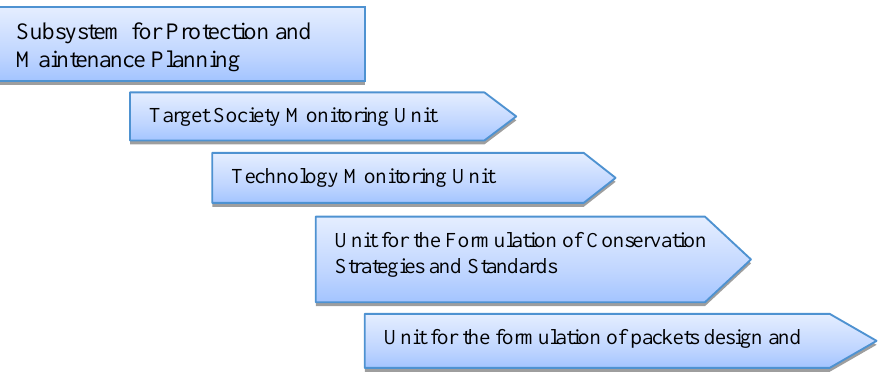
Figure 5: Components of the protection and maintenance planning sub-